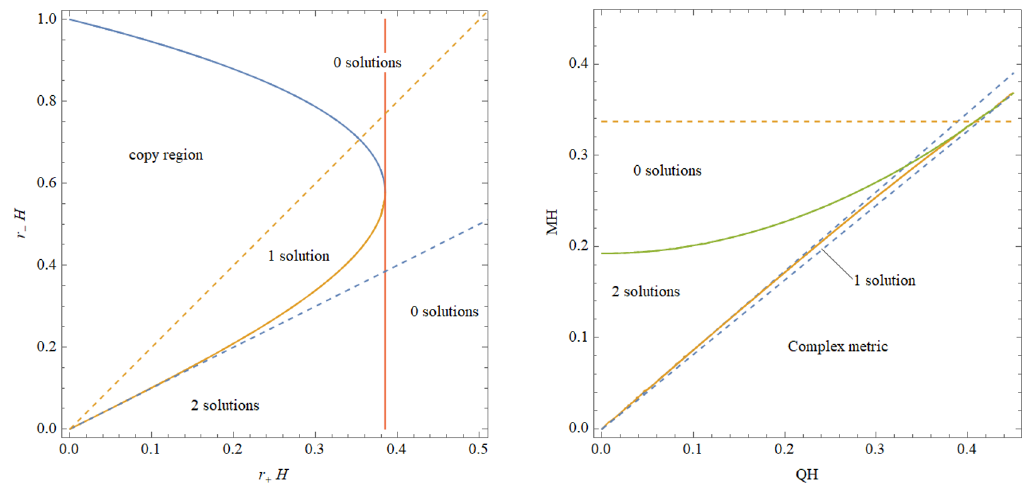
in ( r ) ( left ) and ( QH, MH ) coordinates ( right ). + H, r − H 3 = r , the yellow dotted + − (cid:16) (cid:17) and the one between the 1 √ , 7 √ 6 12 3 (cid:16) (cid:17) (cid:16) √ (cid:17) to give the region with a 1 √ 3 , 7 , 1 √ √ 4 6 12 3 2 2